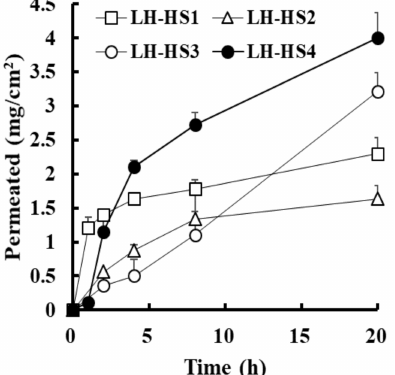
Figure 3. In vitro permeation profile of efinaconazole through the bovine hoof from LH-HS prepara- tions prepared with different hydrophilic enhancers, along with Labrafac PG as a lipophilic enhancer in the Franz diffusion cell model. Data represent mean ± standard deviation ( n =